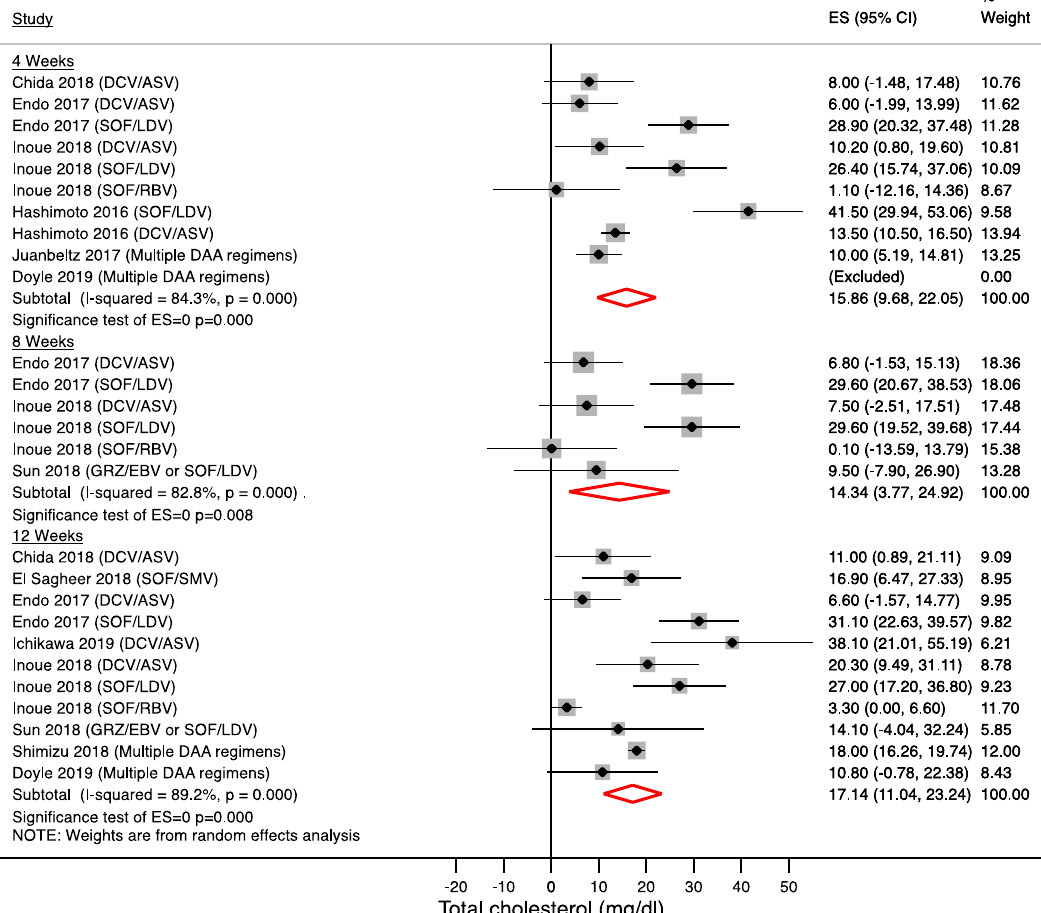
Figure 1. Serum total cholesterol changes during treatment. Forest plot for mean difference (MD) and 95% confidence intervals (CI) for each time-point. DCV/ASV daclatasvir/asunaprevir, SOF/LDV sofosbuvir/ ledipasvir, SOF/RBV sofosbuvir + ribavirin, SOF/SMV sofosbuvir/simeprevir, GRZ/EBV